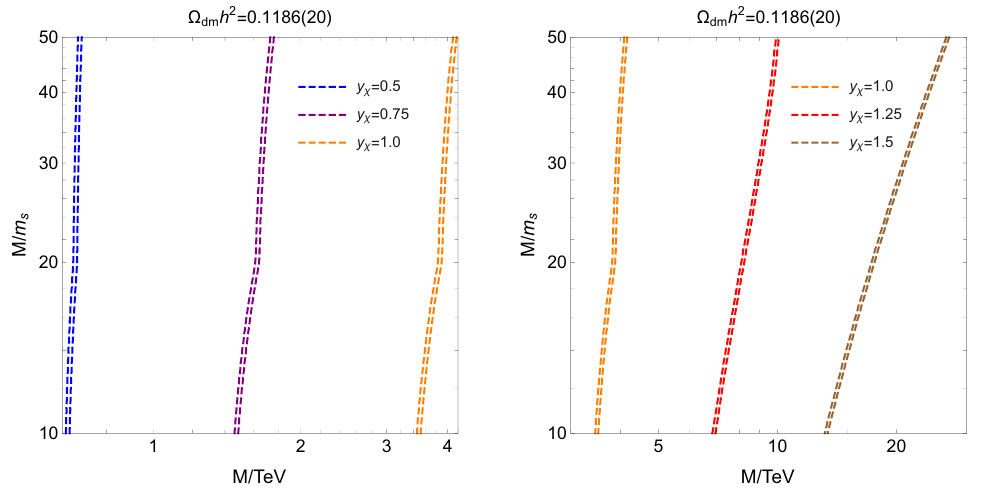
Figure 4 . The curves reproduce the correct dark matter relic abundance in the ( M; M=m s ) plane. Di(cid:11)erent values of the Yukawa coupling y (cid:31) are